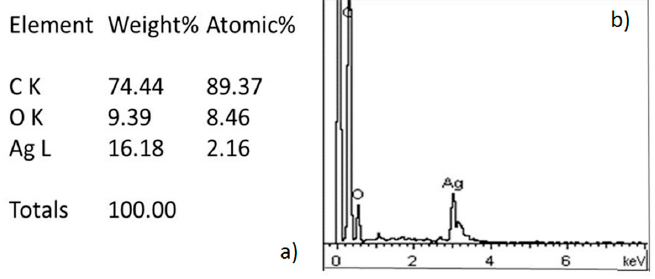
Figure 2. ( a ) Results of the elements ratio obtained for EDS; ( b ) EDS spectrum of Ag-NPs which confirmed